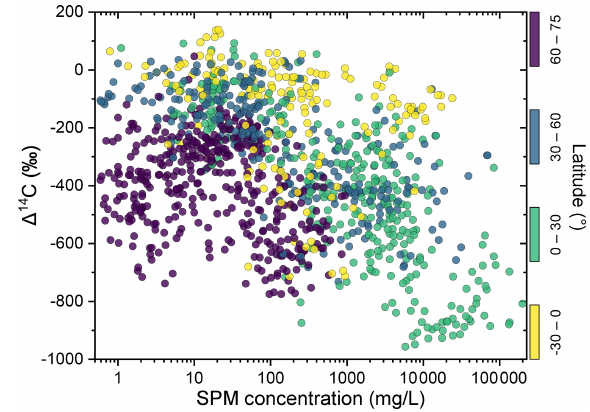
Figure 4. River SPM concentration versus POC concentration ( n = 2135) (both mgL − 1 ). Dotted lines represent contours of con- stant POC content. Colors indicate the POC content from data en- tries in MOREPOC v1.1.